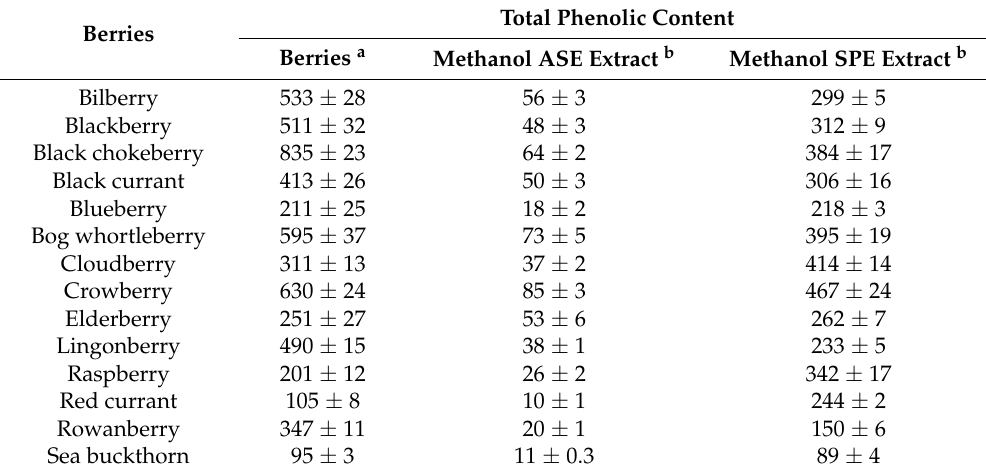
Table 1. Total phenolic content of fresh berries and berry